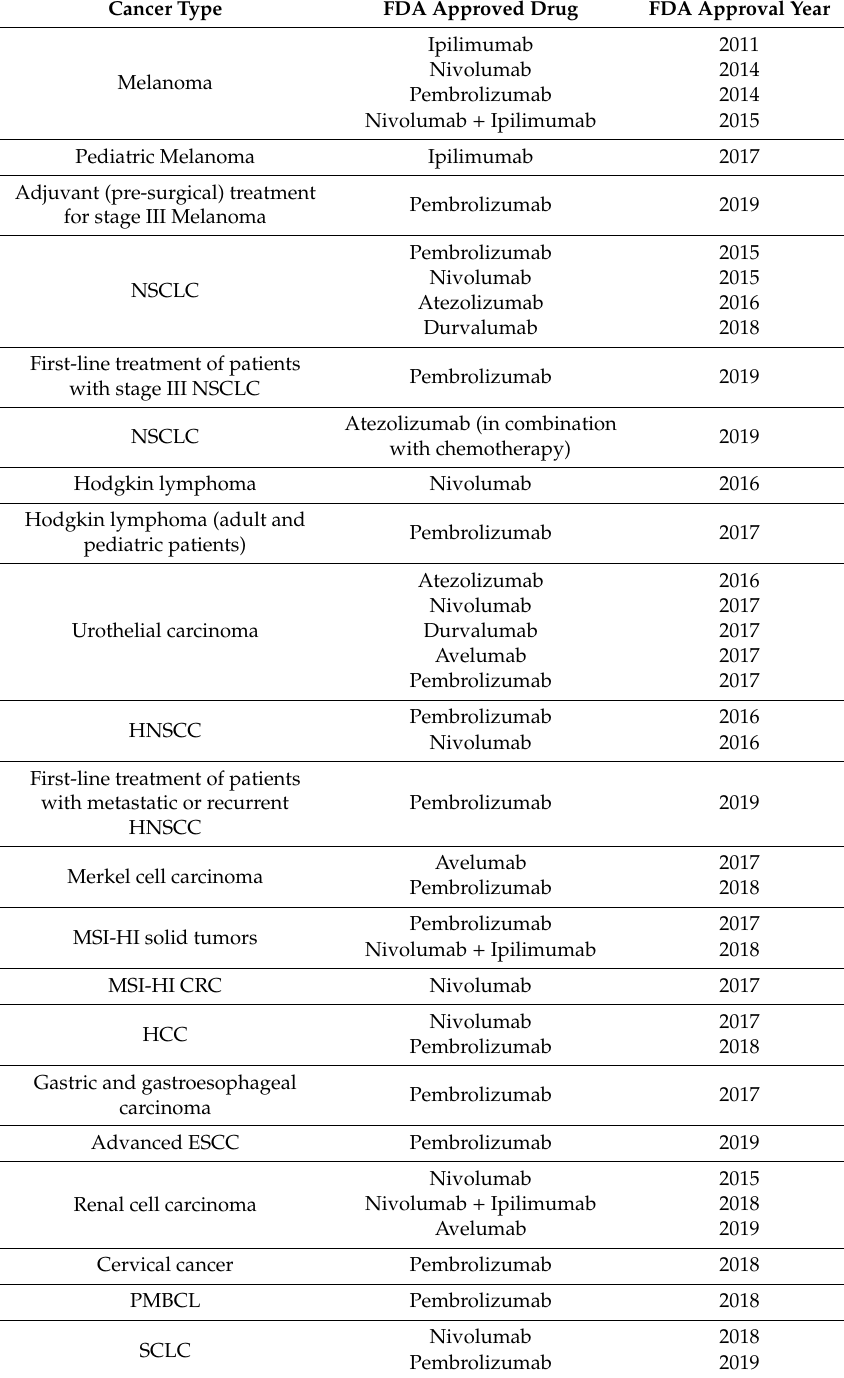
Table 1. FDA approved Immune checkpoint inhibitors for di ff erent types of cancers